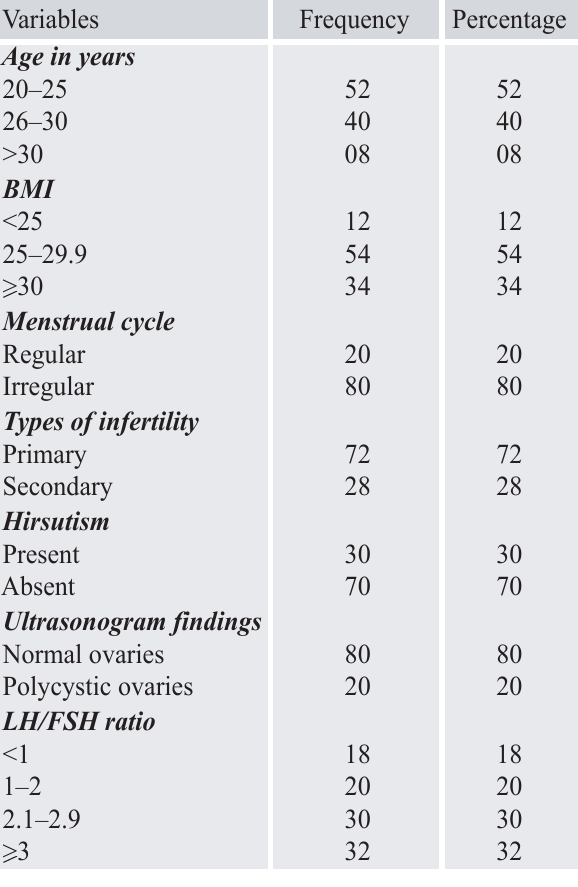
Table I: Age distribution, BMI, menstrual cycle, types of infertility, presence of hirsutism, ultrasonographic findings and LH/FSH ratio